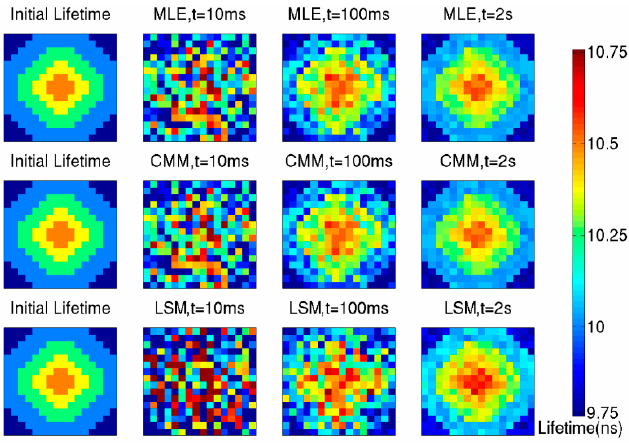
Figure 14. The simulation result of No. 2 picture.